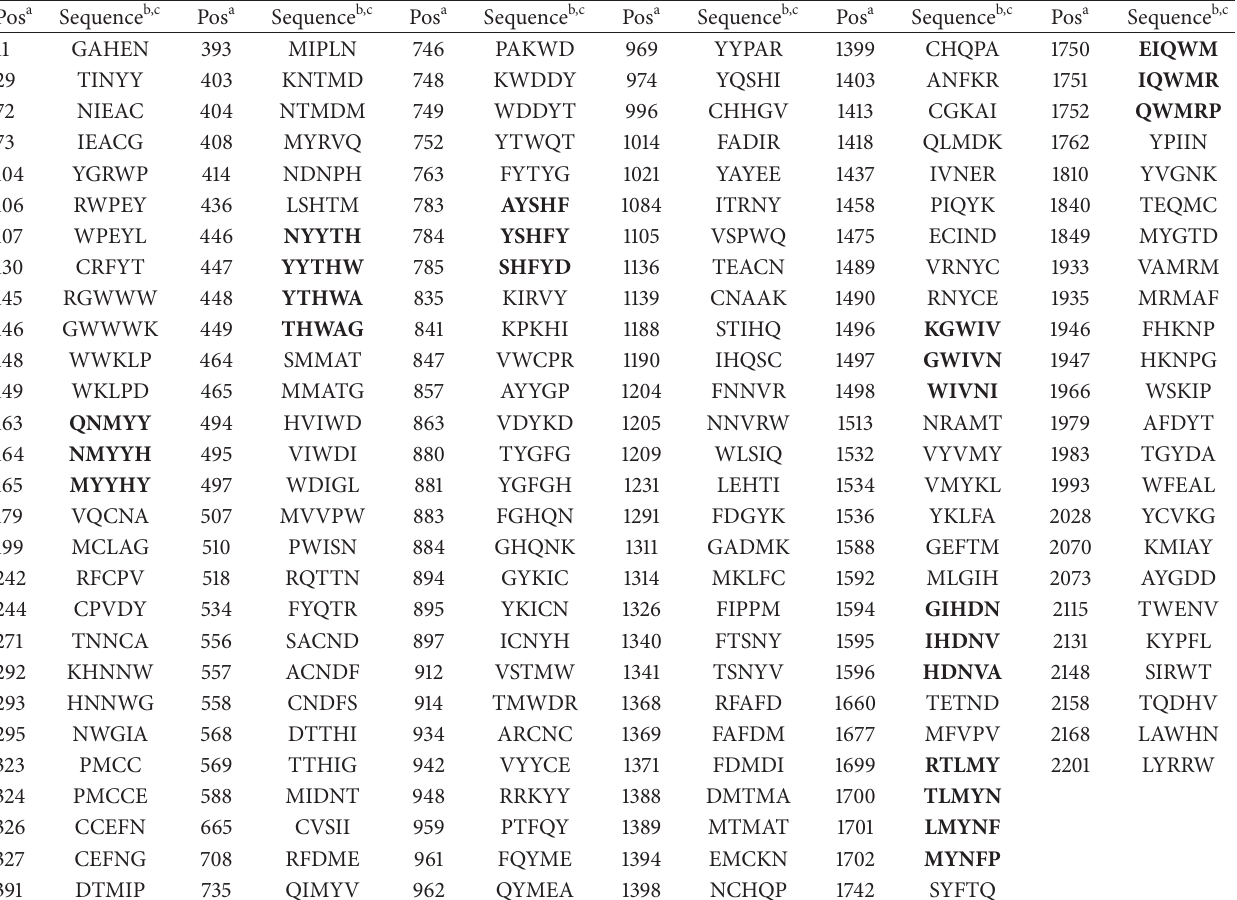
Table 1: Pentapeptides unique to PV type 1, strain Mahoney, and absent in the human